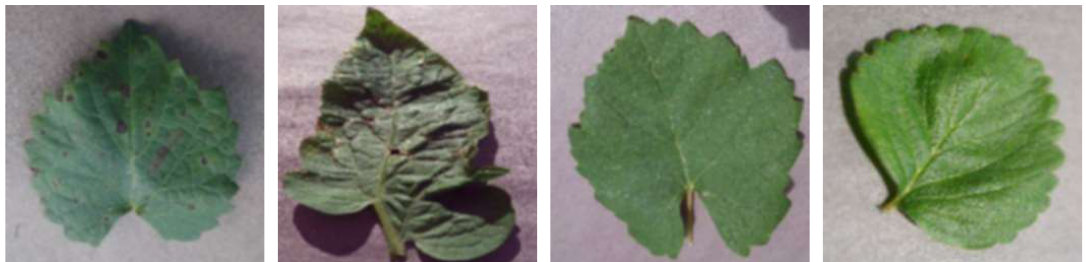
Figure 6. Sample augmented images using DCGAN.